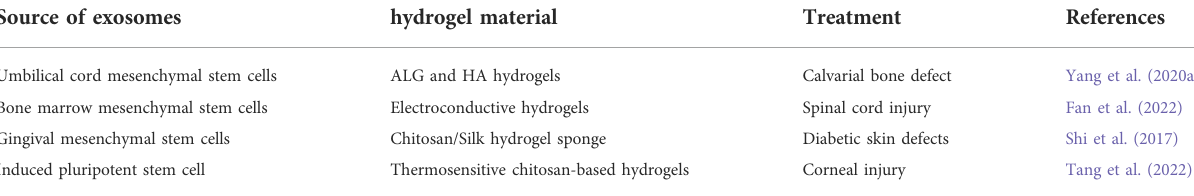
TABLE 2 The list of sectional diverse exosomes and hydrogels treatment to